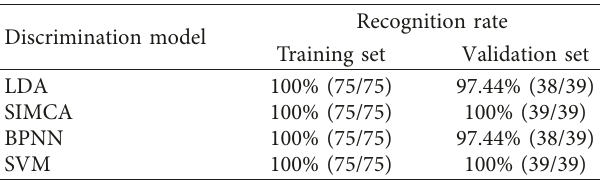
Table 7: Performance comparison of 4 kinds of discrimination